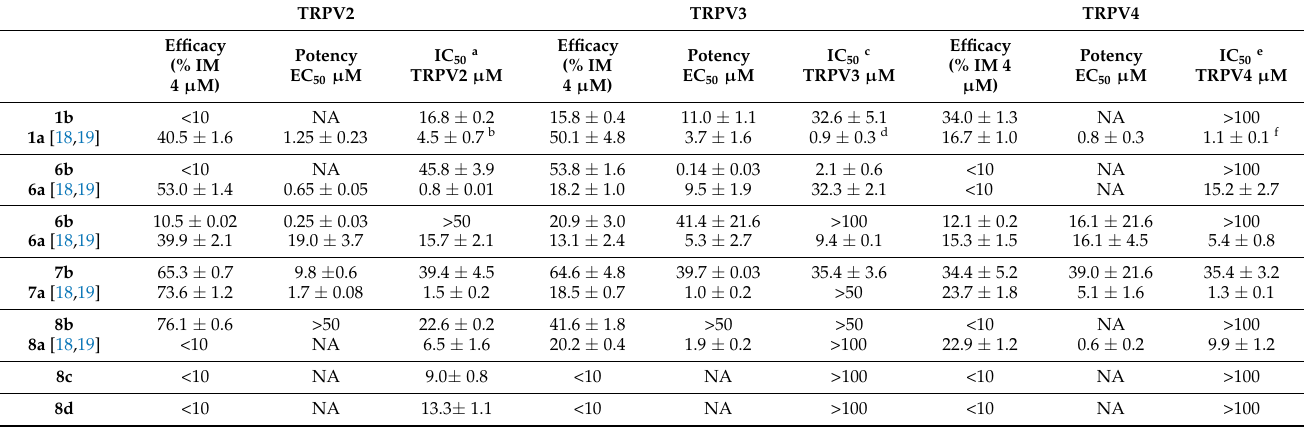
Table 2. Efficacy, potency, and inhibitory effect on TRPA1, TRPV1, and TRPM8 channels. TRPV2 TRPV3